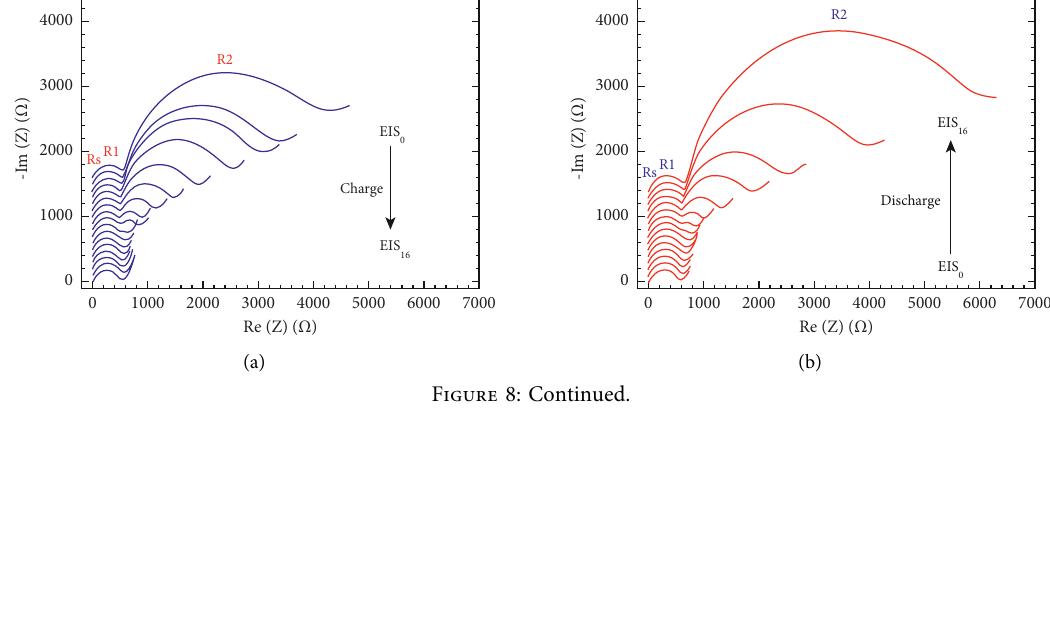
Figure 7: Titration curve and plot of the logarithm of diffusion coefficient D (b).